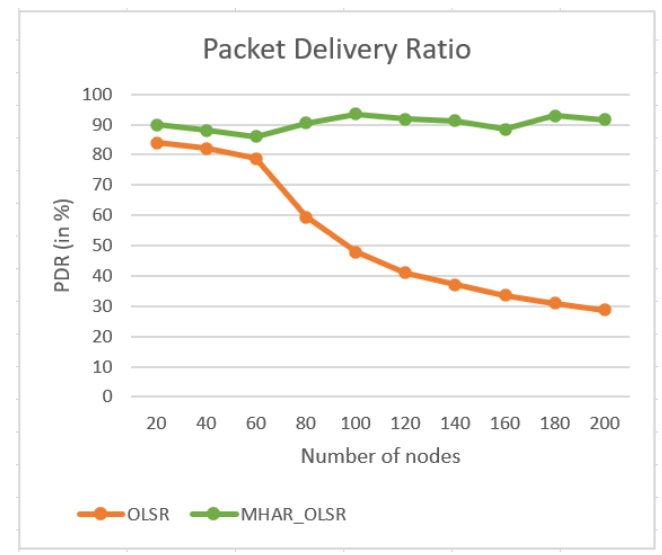
Figure 11. Packet delivery ratio as function of